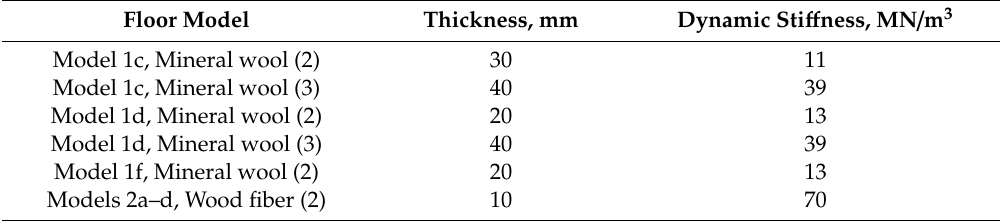
Table 4. Specification of the resilient materials used in all floating floors.